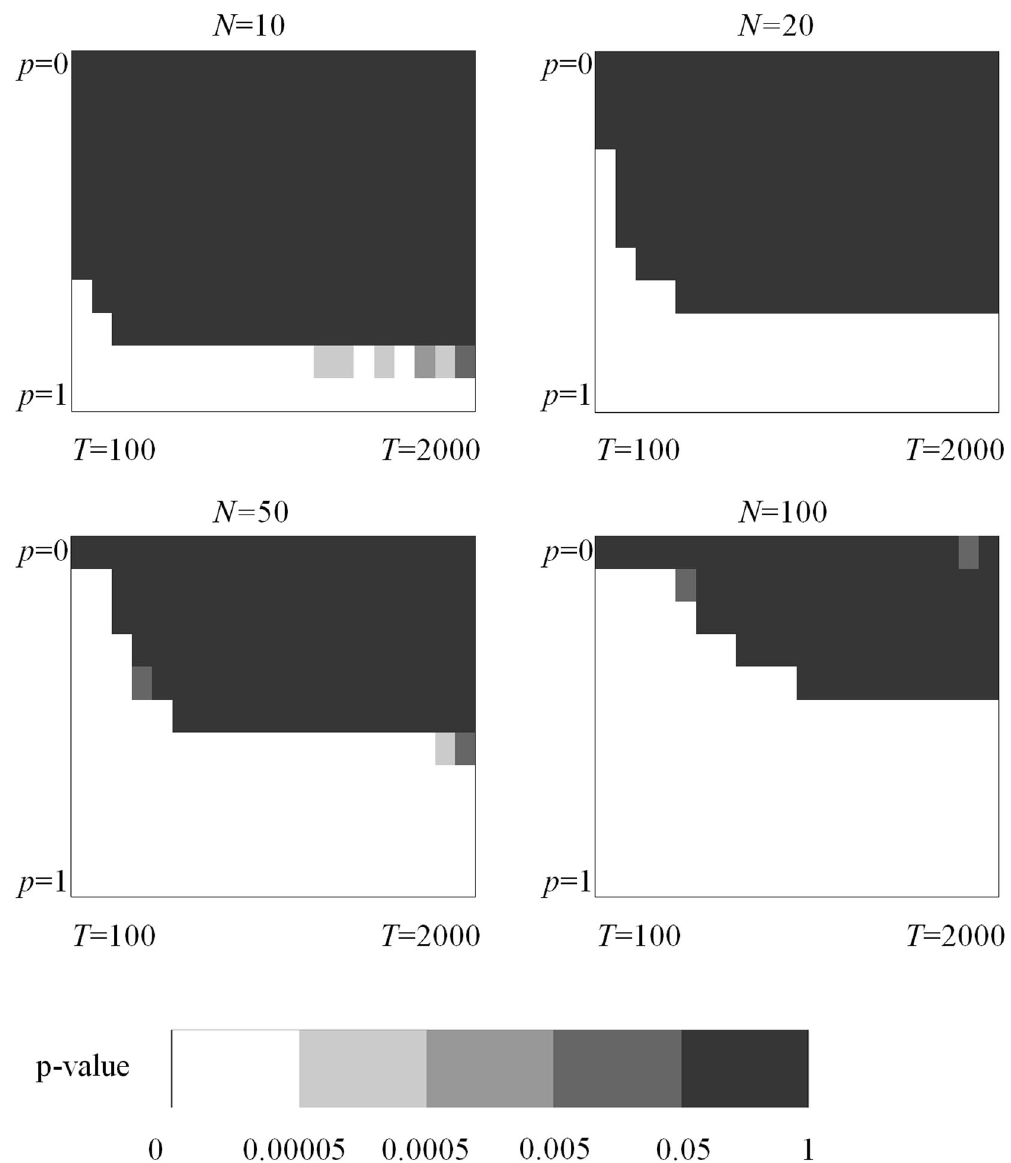
Fig. 9 The effect of the number of actors N on model behavior. Explanation of the fi gure is exactly the same as in Fig. 5. In general, more non-black squares appear as N increases, implying solitary behavior is favored. Values for other parameters are: D = 0.002 , M = 1000, Q = 1, S = 1, E =